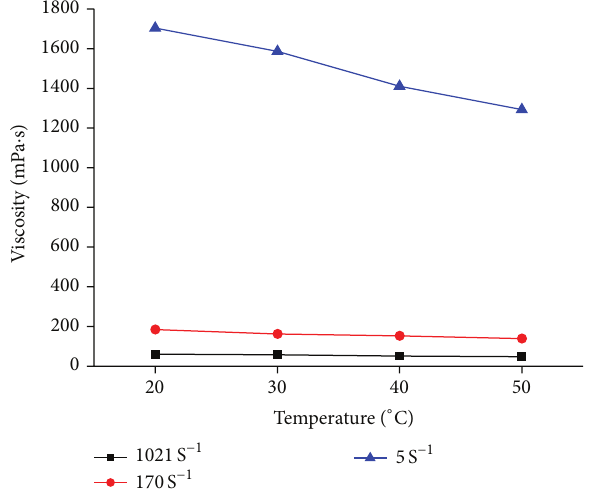
Figure 5: Rheological property under different temperature and the same shear rate.